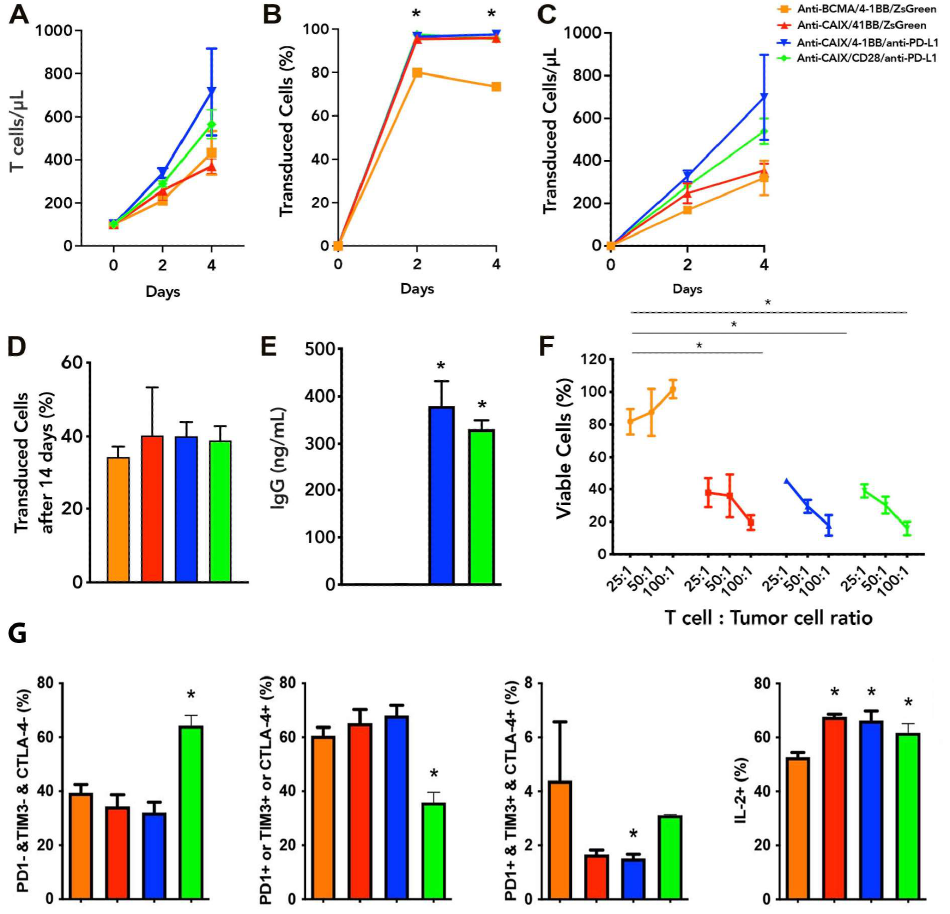
Figure 1. Functional characterization of chimeric antigen receptor (CAR) T cells and CAR T cell exhaustion in vitro. ( A ) T cells proliferation analysis two and four days after transduction with Anti carbonic anhydrase IX (CAIX) CD8alpha/4-1BB CAR-expressing anti-programmed cell death ligand-1 (PD-L1) IgG4 (anti-CAIX/4-1BB/anti-PD-L1 IgG4), or ZsGreen (anti-CAIX/4-1BB/ZsGreen), anti CAIX CD28 CAR-expressing anti-PD-L1 IgG4 (anti-CAIX/CD28/anti-PD-L1 IgG4) compared to anti-B cell maturation antigen (BCMA) 4-1BB CAR-expressing ZsGreen (anti-BCMA/4-1BB/ZsGreen negative control). ( B ) Percentage of CAR+ T cells and ( C ) Proliferation of CAR+ T cells two and four